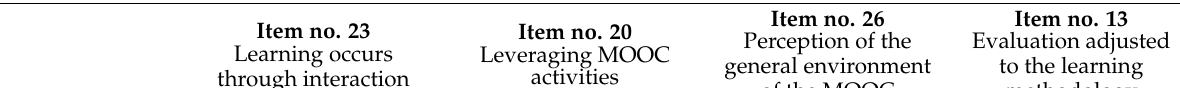
Item no. 20 Leveraging MOOC activities